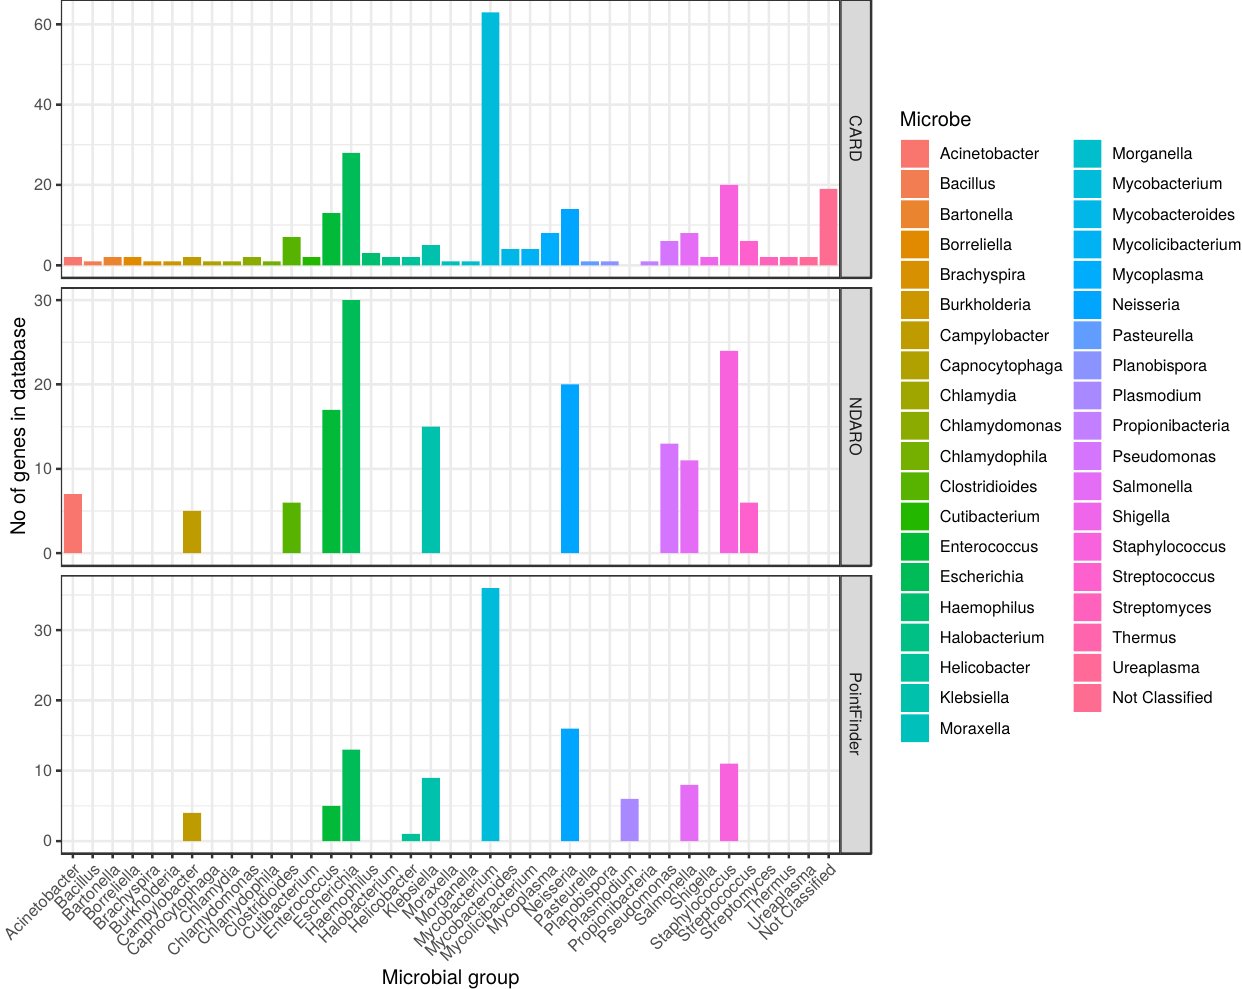
Figure 3. Number of genes conferring resistance through mutations for each microbial genus in CARD, NDARO and MEGARes databases. Genes conferring resistance through mutations was calculated at the genus level for each microbe stored in each database. Only one group could not be summarized at the genus level (propionibacteria). Microbial genus is on the x axis and the number of genes associated with each group in the database is represented by the y axis. Rows show the data separately for each database. Columns are colored by the microbial